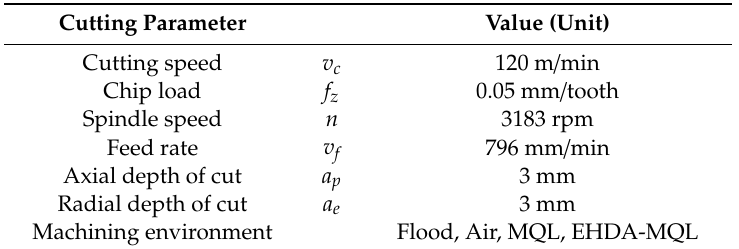
Table 1. Cutting parameters used for